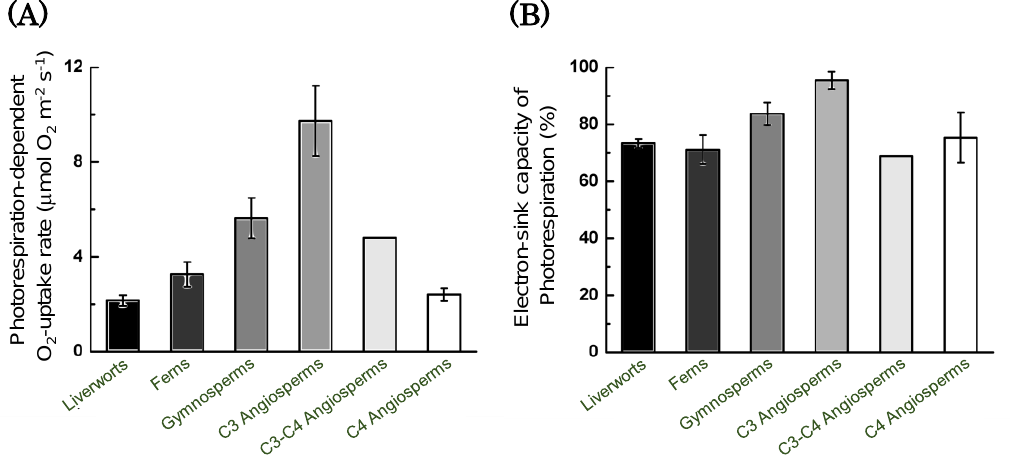
Figure 7. Evolution of tight coupling between the light and the dark reactions in photosynthesis. Upon spreading on the surface of the earth, oxygenic photosynthetic organisms inevitably metabolized 2-phosphoglycolate to regenerate 3-phosphoglycerate via the photorespiration pathway, because ribulose 1,5-bisphophate (RuBP) carboxylase/oxygenase (Rubisco) catalyzes both RuBP carboxylation and oxygenation under atmospheric conditions. Consequently, photorespiration inevitably accompanies photosynthetic CO 2 fixation. In C3 angiosperms, both photosynthetic CO 2 fixation and photorespiration have become the main electron sinks in the photosynthetic process. Hanawa et al. [98] found that photorespiration activity increased with the evolution of oxygenic photosynthetic organisms. Photorespiration activity is evaluated as a photorespiration-dependent O 2 -uptake at the CO 2 compensation point, at which point its activity peaks [66]. ( A ) Photorespiration activity increases with the evolution of oxygenic photosynthetic organisms from liverworts to C3 angiosperms through ferns and gymnosperms. ( B ) The electron sink capacity of photorespiration reaches its maximum in C3 angiosperms. The activities of flavodiiron (FLV)-dependent photosynthetic linear electron flow and other alternative photosynthetic linear electron flow (AEF) decrease upon the evolution of oxygenic photosynthetic organisms from liverworts to C3 angiosperms through ferns and gymnosperms. On the other hand, C3-C4 and C4 plants show lower photorespiration activity, and other electron sinks function at the CO 2 compensation point. Data are from Hanawa et al. [98].